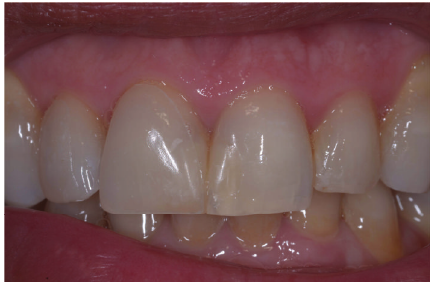
Figure 4: Intraoral try-in of the mock-up and provisional